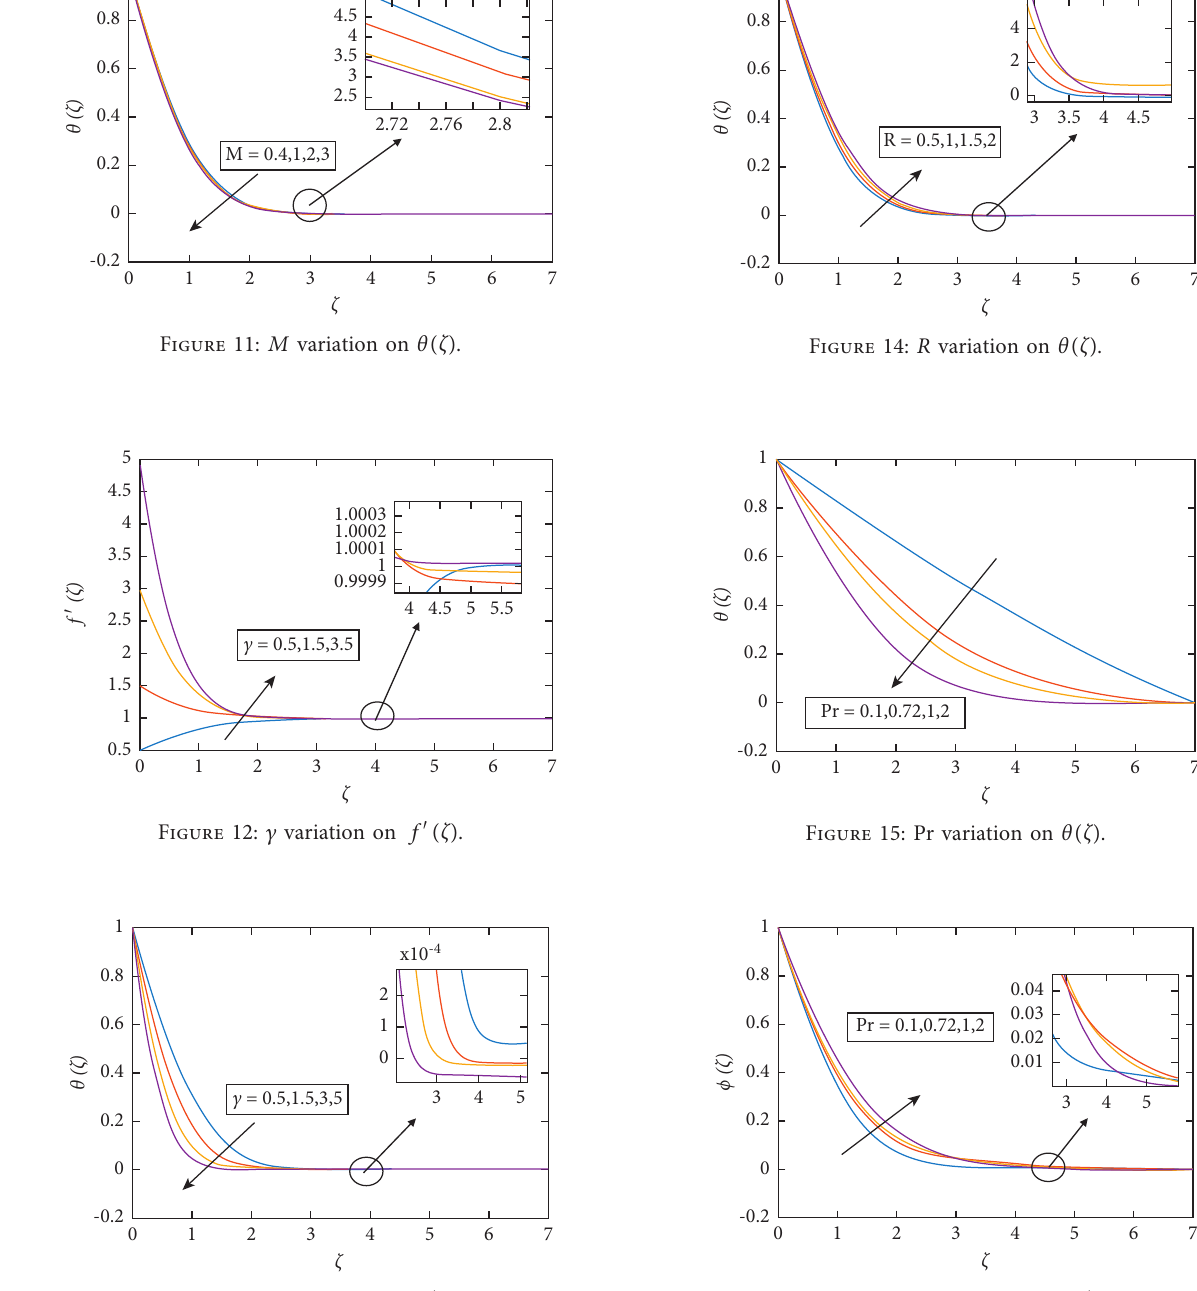
Figure 13: c variation on θ ( ζ ) .